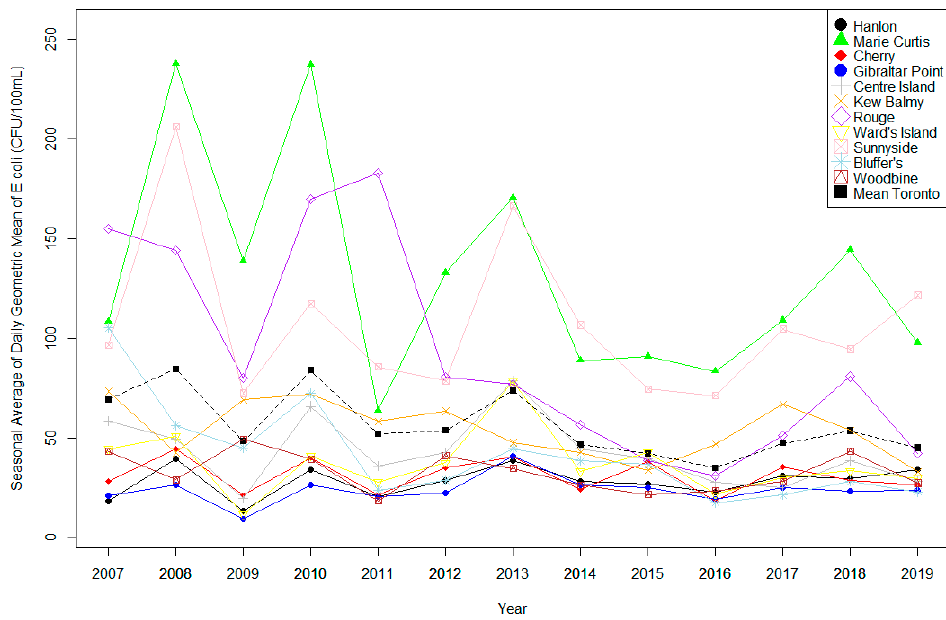
Figure 2. Mean annual E. coli geometric mean at Toronto Beaches, 2007–2019.